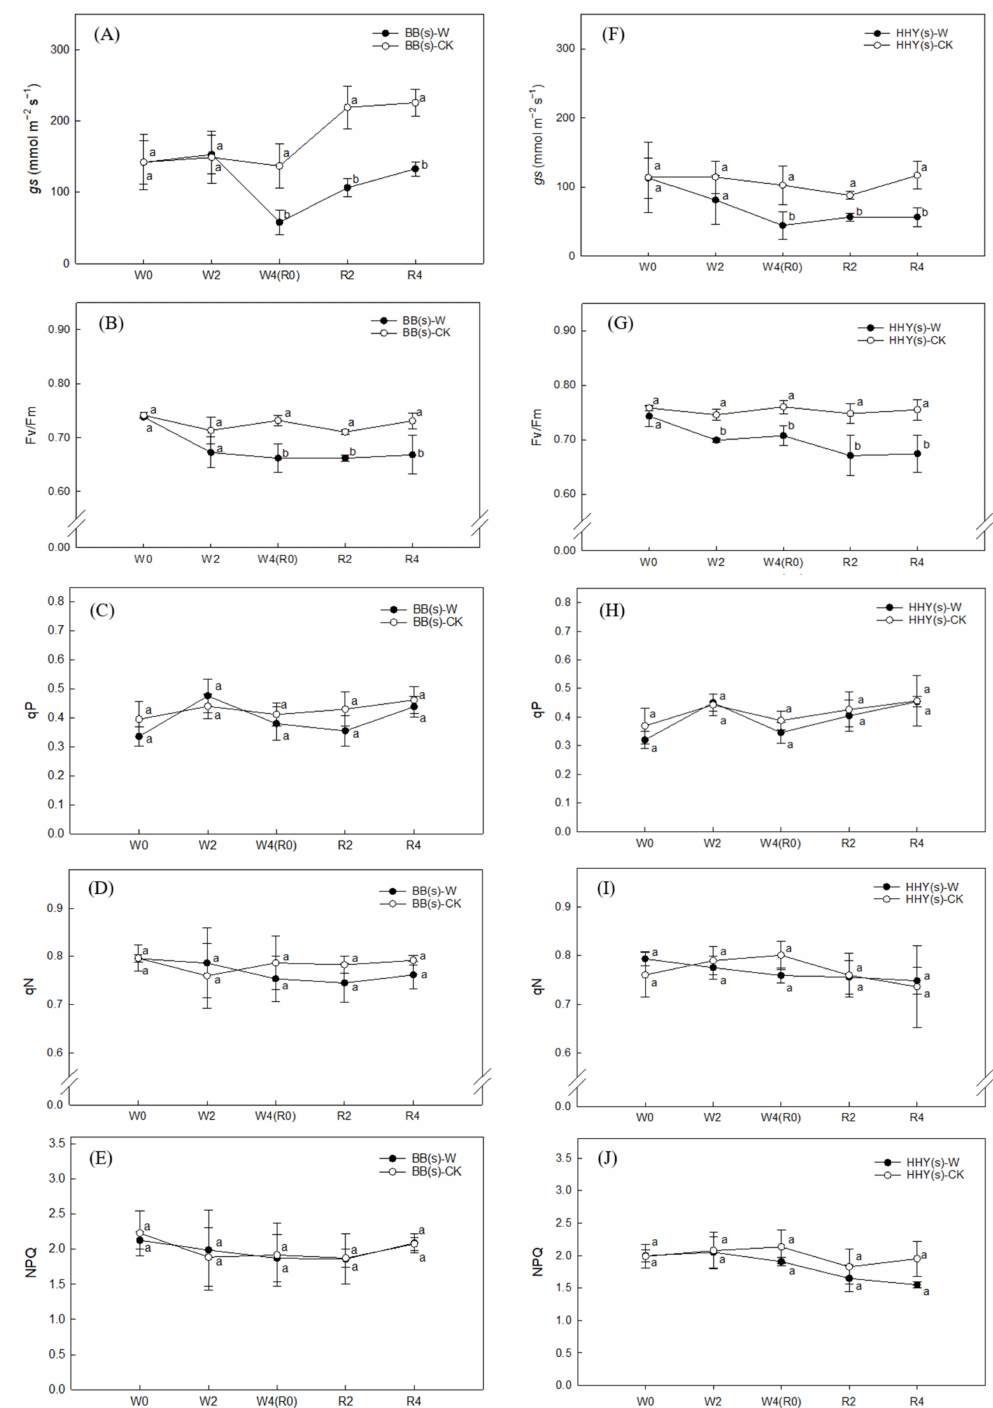
Figure 1. The stomatal conductance (gs) and chlorophyll fluorescence parameters of two cultivar own- rooted seedlings during waterlogging (W0, W2, and W4) and the post-waterlogging recovery period (R0, R2, and R4). ( A – E ) Performance of cultivar ‘Black-Beauty’ (BB). ( F – J ) Performance of cultivar ‘Hung-Hsin-Yuan’ (HHY). Bars indicate the standard deviation of three replicates, and different letters represent the significant difference between the treatments on the same investigated